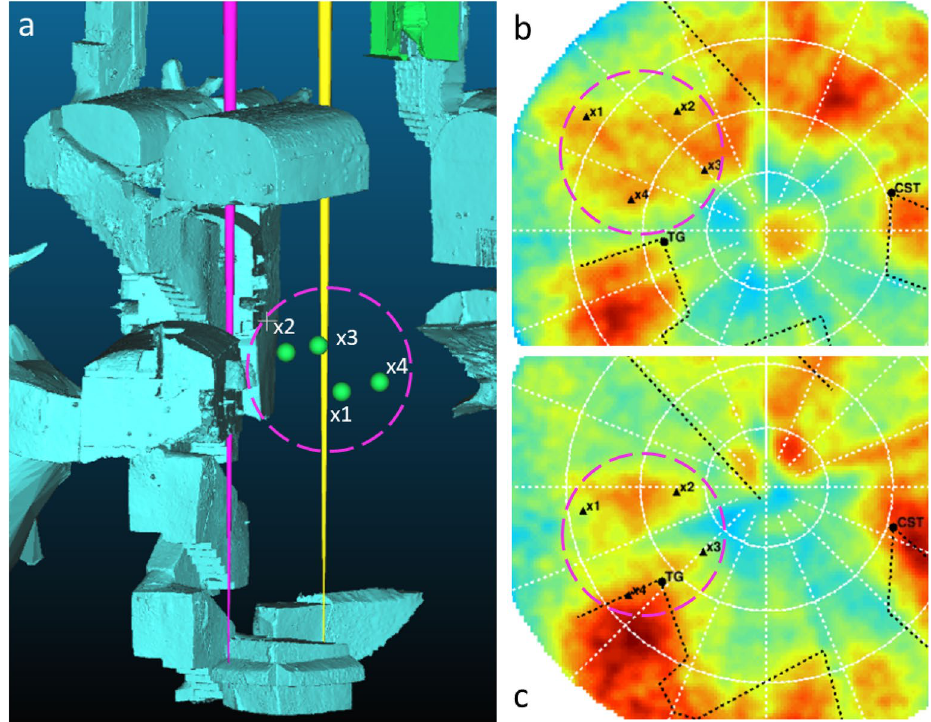
Figure 7. ( a ) 3D view of the site with the four inferred reference points x 1 to x 4 reported as green spheres. ( b , c ) are the zoomed view of the region of interest as seen from the two detectors. Black triangles present the projections on the muography image of the 3D points x 1 to x 4 .